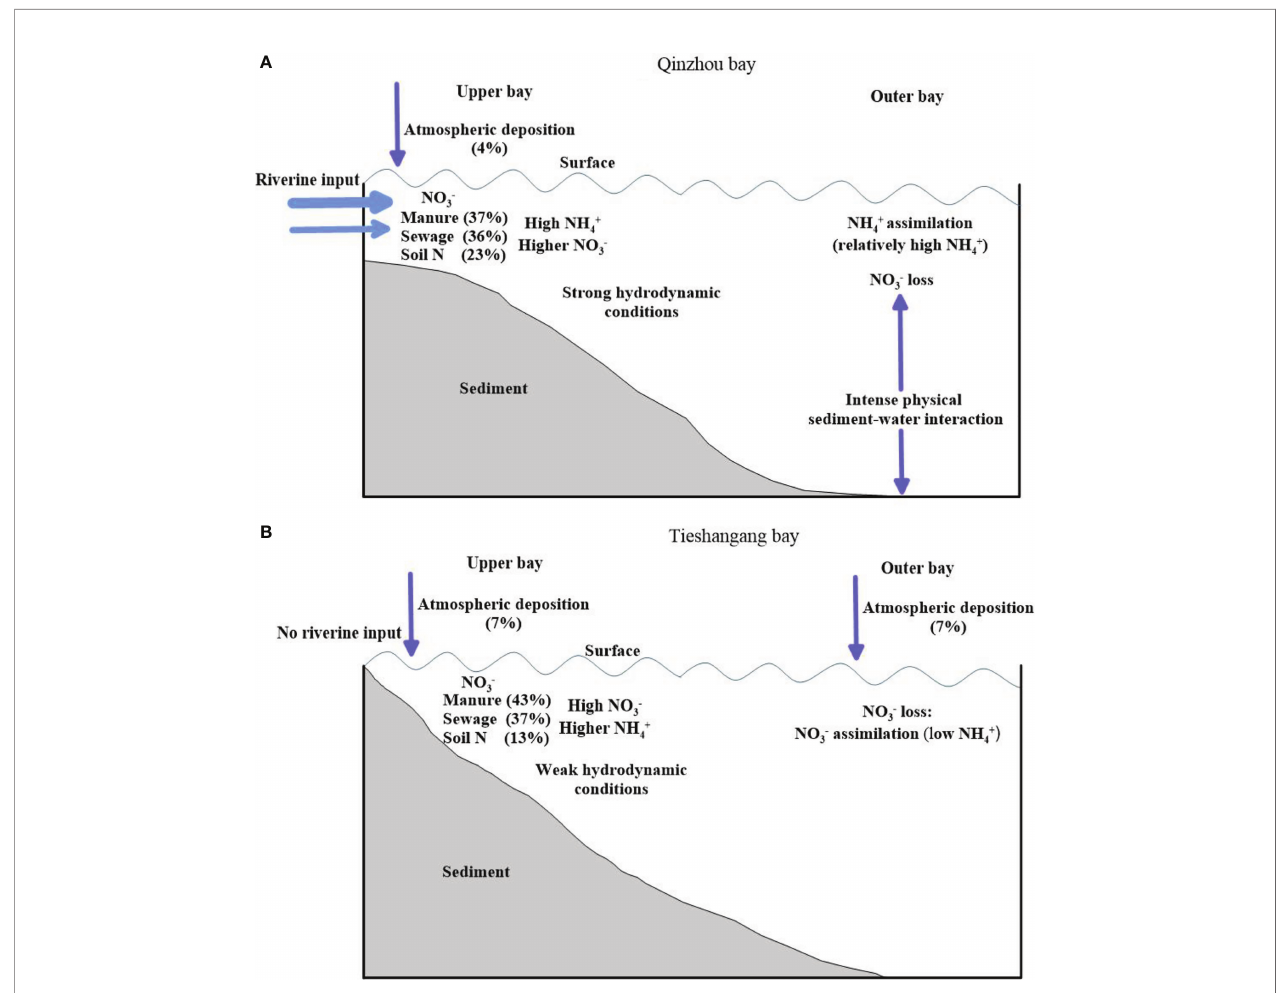
FIGURE 10 | Conceptual diagram of sources and cycling of nitrogen between a bay with riverine input (A) and a bay without riverine input (B) in the Beibu